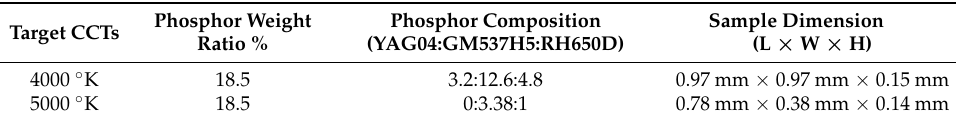
Figure 3. The CSP LED samples under 120 mA during the step-stress accelerated degradation test (SSADT) process. (Top: 4000 °K samples; Bottom: 5000 °K samples).